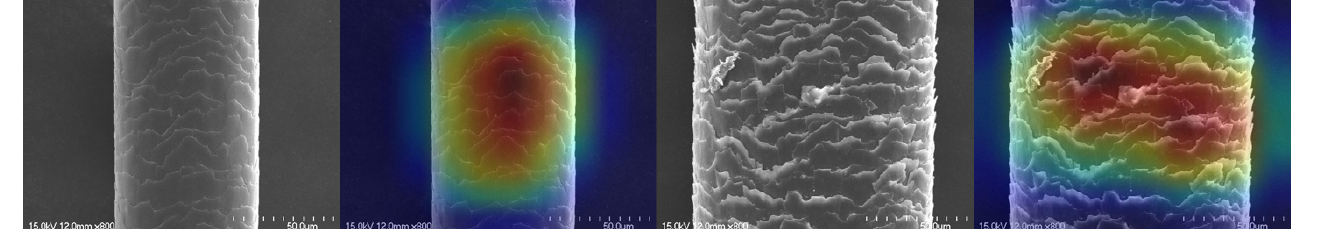
Table 3. Classification error (%) on SEM Hair dataset.